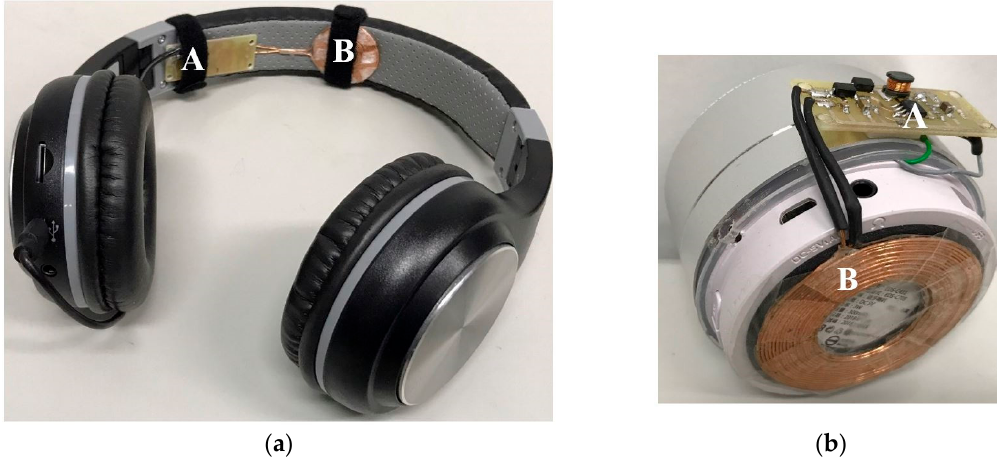
Figure 19. The developed wireless receiver module installation: ( a ) on the wireless headphone (part A is receiver module and part B is receiver coil); ( b ) on wireless portable audio speaker (part A is receiver module and part B is receiver coil).